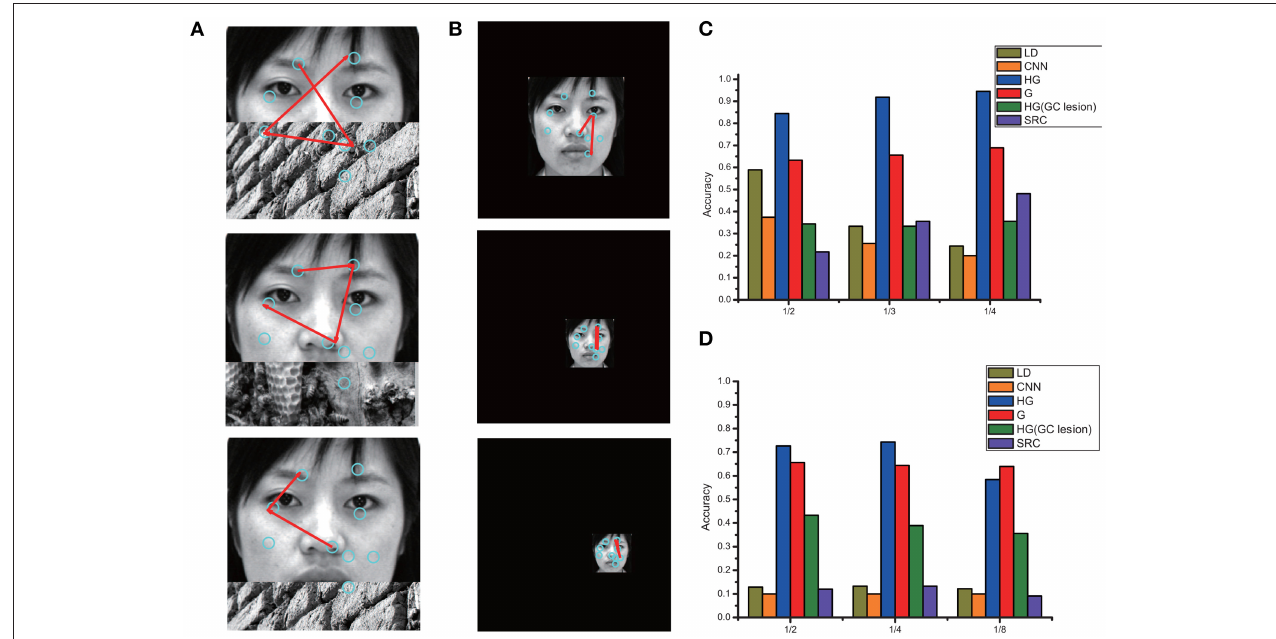
FIGURE 9 | (A) Examples of partially occluded stimuli with different proportions of occlusion (1/2,1/3,1/4). (B) Examples of downscaled images with different scaling ratios (1/2,1/4,1/5). The recognition accuracy of different models on the occluded and downscaled images are compared in (C,D) ,